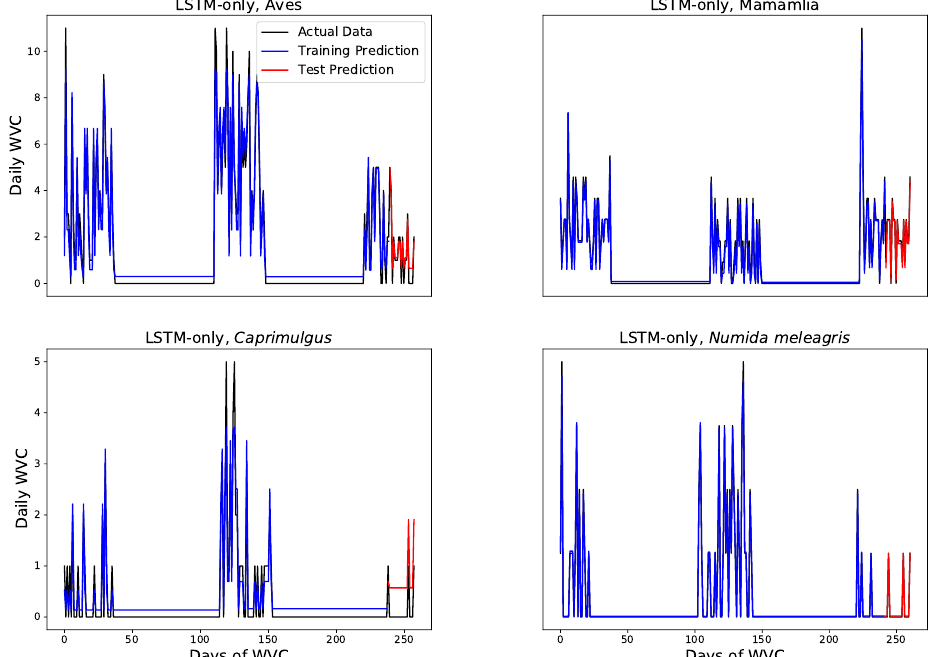
Figure 10. A time series of daily wildlife roadkill showing actual data and predicted data using LSTM-only on the Aves (top-left panel), Mammalia (top-right panel), Caprimulgus (bottom-left panel), and Numida meleagris (bottom-right panel)